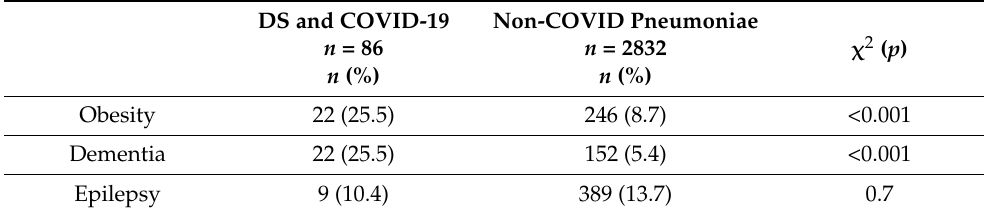
Table 2. Frequency of obesity, dementia, and epilepsy comorbidities in individuals with Down syndrome (DS) and COVID-19 compared to individuals non-COVID-19 pneumoniae.